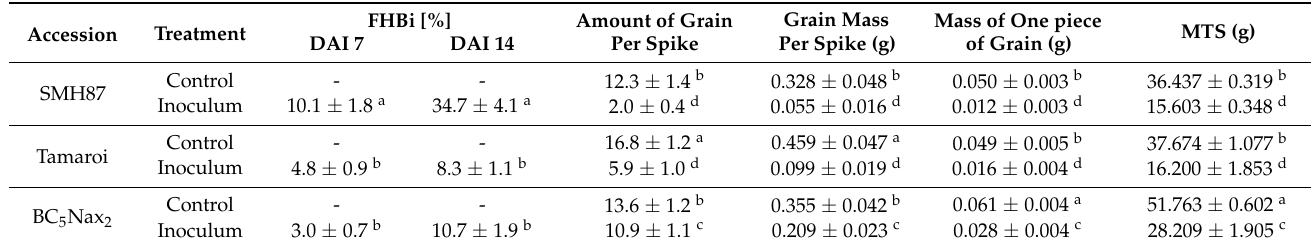
Table 3. Fusarium head blight index (FHBi) evaluated 7 and 14 days (DAI 7 and DAI 14) after spike inoculation with F. culmorum and yield components of three durum wheat genotypes.